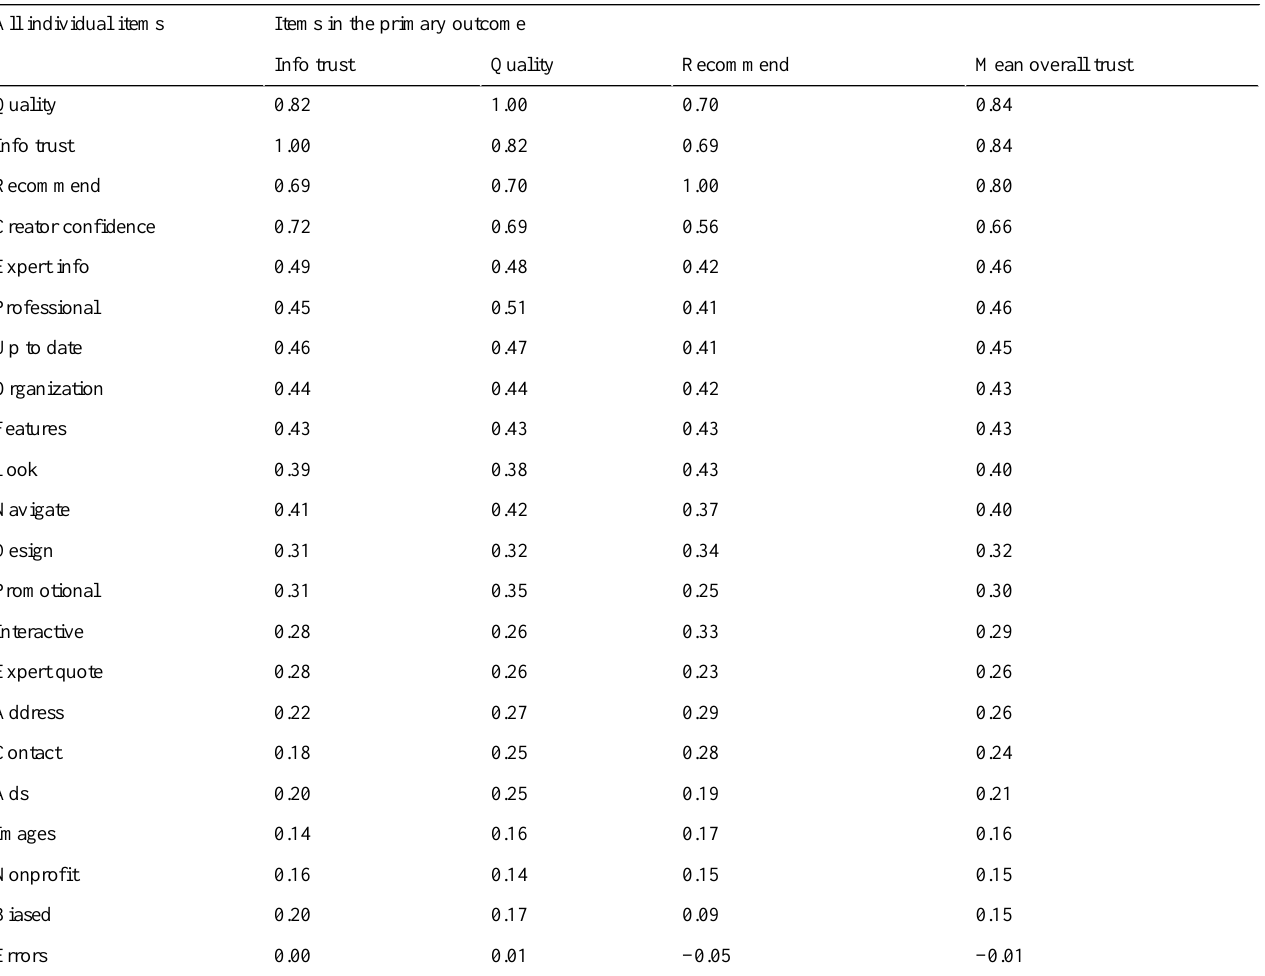
Table 6. Correlation coefficients between items in the primary outcome of mean overall trust and all individual items for Louisiana alone. Items in the primary outcomeAll individual items